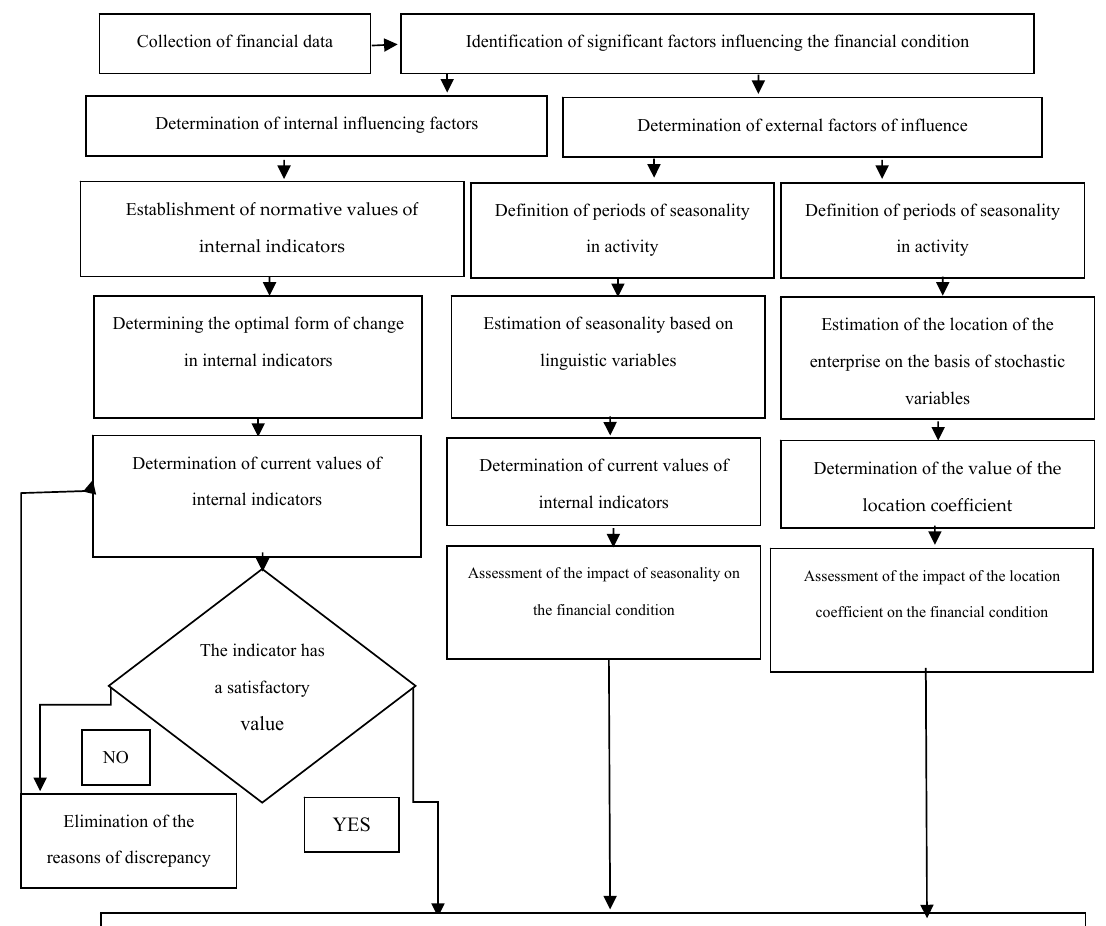
Figure 1. Algorithm for modeling the system for assessing the financial stability of the service sector enterprise (author’s study).